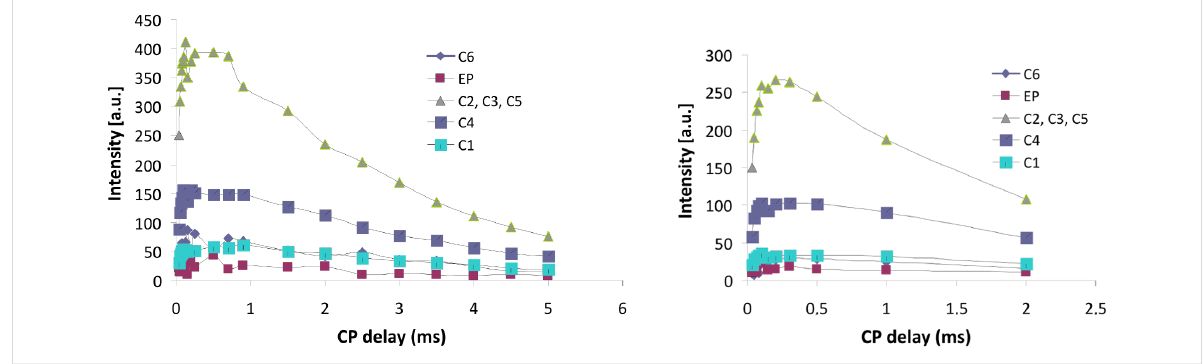
Figure 7: Cross-polymerization (CP) build-up curve of the 13 C resonances with variable contact time for polymers D1 (left) and D3 (right).